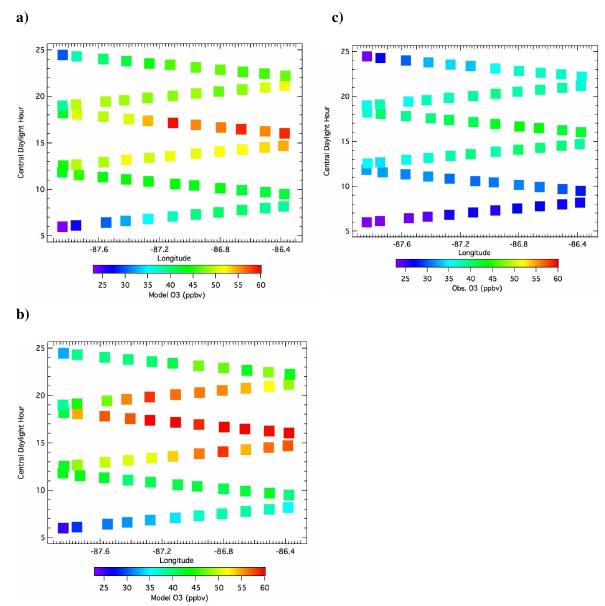
Figure 11. Median O 3 from (a) 1 to 24h CMAQ forecasts, (b) 25 to 48 CMAQ forecasts and (c) ferry